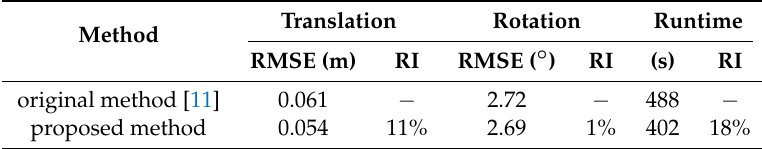
Table 4. Trajectory results of RGB-D SLAM with fr1/floor